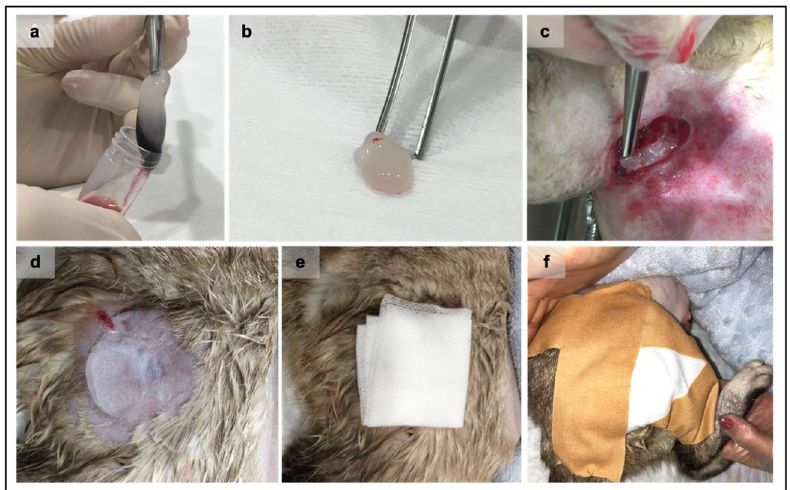
Figure 1. Representation of the Platelet-rich fibrin (PRF) clots grafting procedure. After the centrifugation and consolidation step, the PRF clot was gently removed from the tube ( a ) using both aseptic instruments and technique. The fibrin clot ( b ) is ready to be grafted after the removal of the red fraction. The PRF grafting procedure at wound bedding always applied an aseptic technique ( c ). Sterile petroleum jelly is applied immediately above the wound ( d ) to maintain the PRF in the wound site, followed by the placement of a paraffin gauze bandage ( e ). Finally, a closed bandage was performed ( f ). Table 1. Characterization of canine donors .